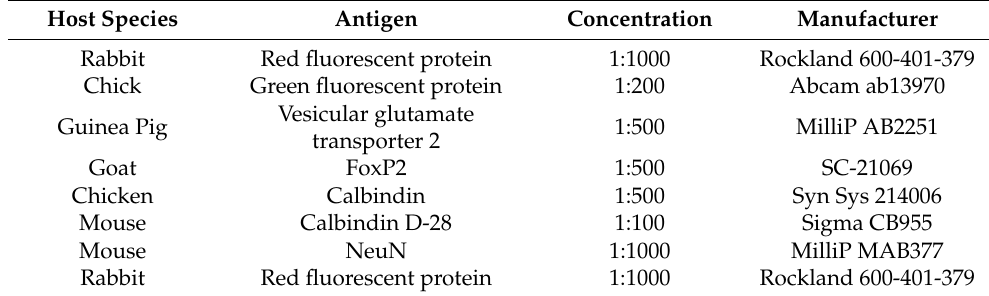
Table 1. Primary antibodies.